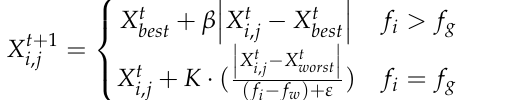
measurement vector. The value of each dimension of each measurement vector represents different specific physical quantities in the power network, namely active power, reactive power, line active current and line reactive current from Equation (2). The measurement vectors are classified with the SSA–CNN classification model proposed in this paper, where each dimension of the measurement vectors represents a label. After the classification model, the output classification vectors are also dimensional vectors, but the elements in the classification vectors are all 0 and 1 because, after the measurement vectors pass through the last layer of the CNN that is the fully connected layer, the data can be